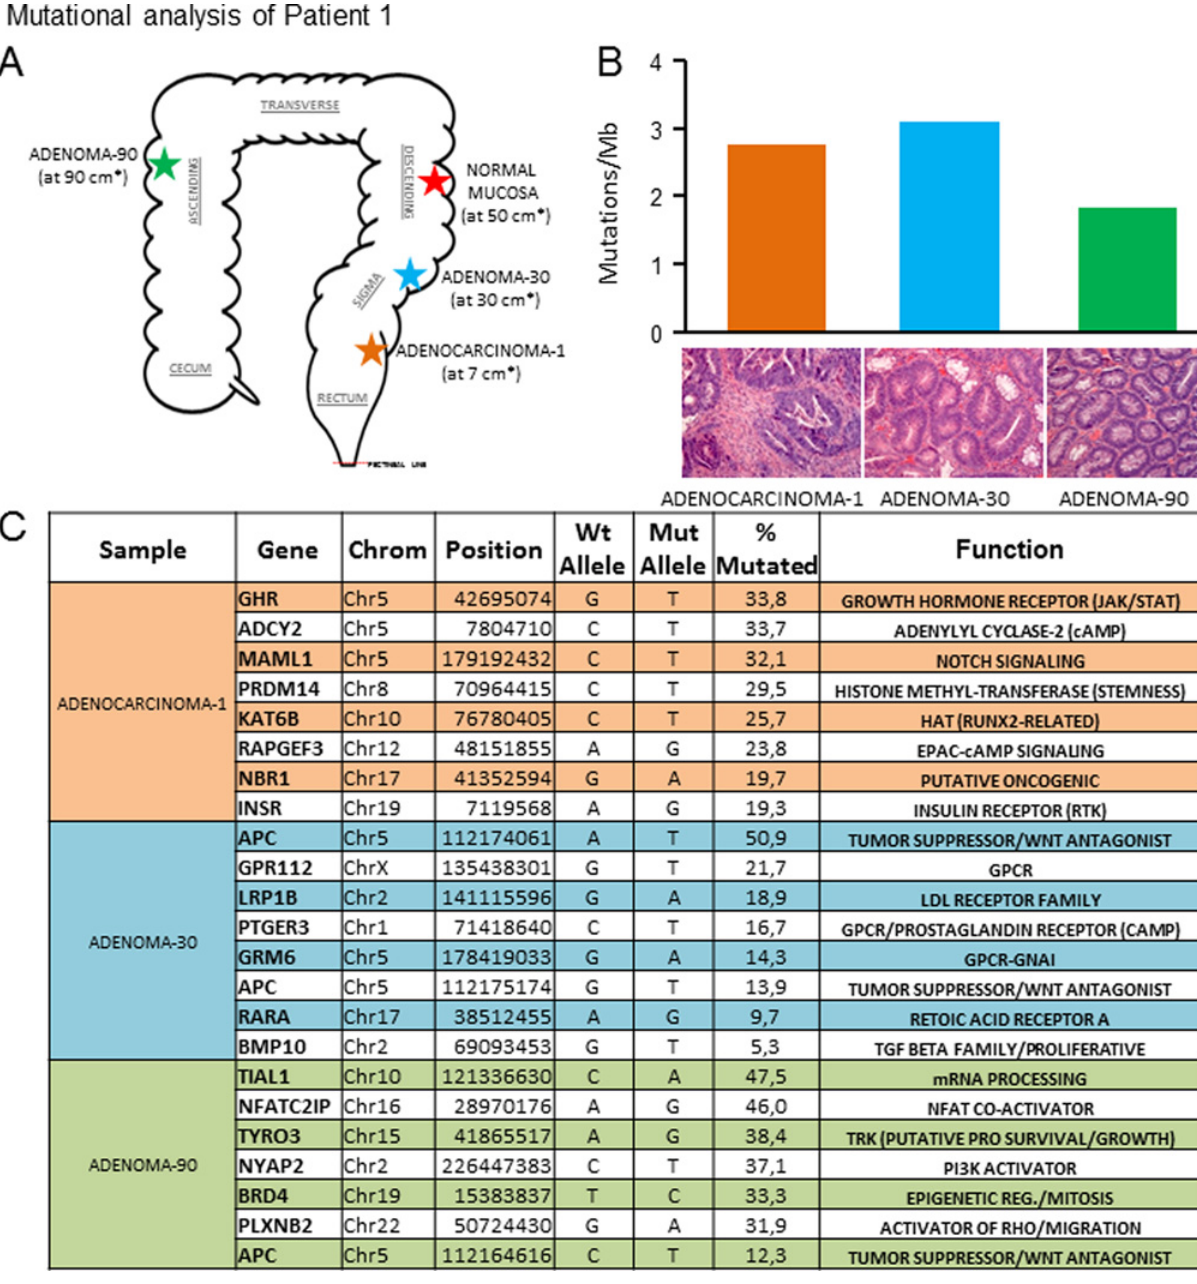
Fig 1. Mutation analysis of patient 1. A) Scheme showing an approximate representation of the location of each lesion analysed. The distance ( * , in cms) from the pectineal line (red dots) is shown. B) Mutational index (number of mutations/Mb) found in the indicated sample from the primary NGS analysis. H&E pictures are representative of each lesion studied by NGS. C) Validated mutations found in a secondary targeted NGS analysis of the indicated samples. Chrom: chromosome; % mutated: percentage of mutant nucleotides found in the corresponding gene within the same sample.